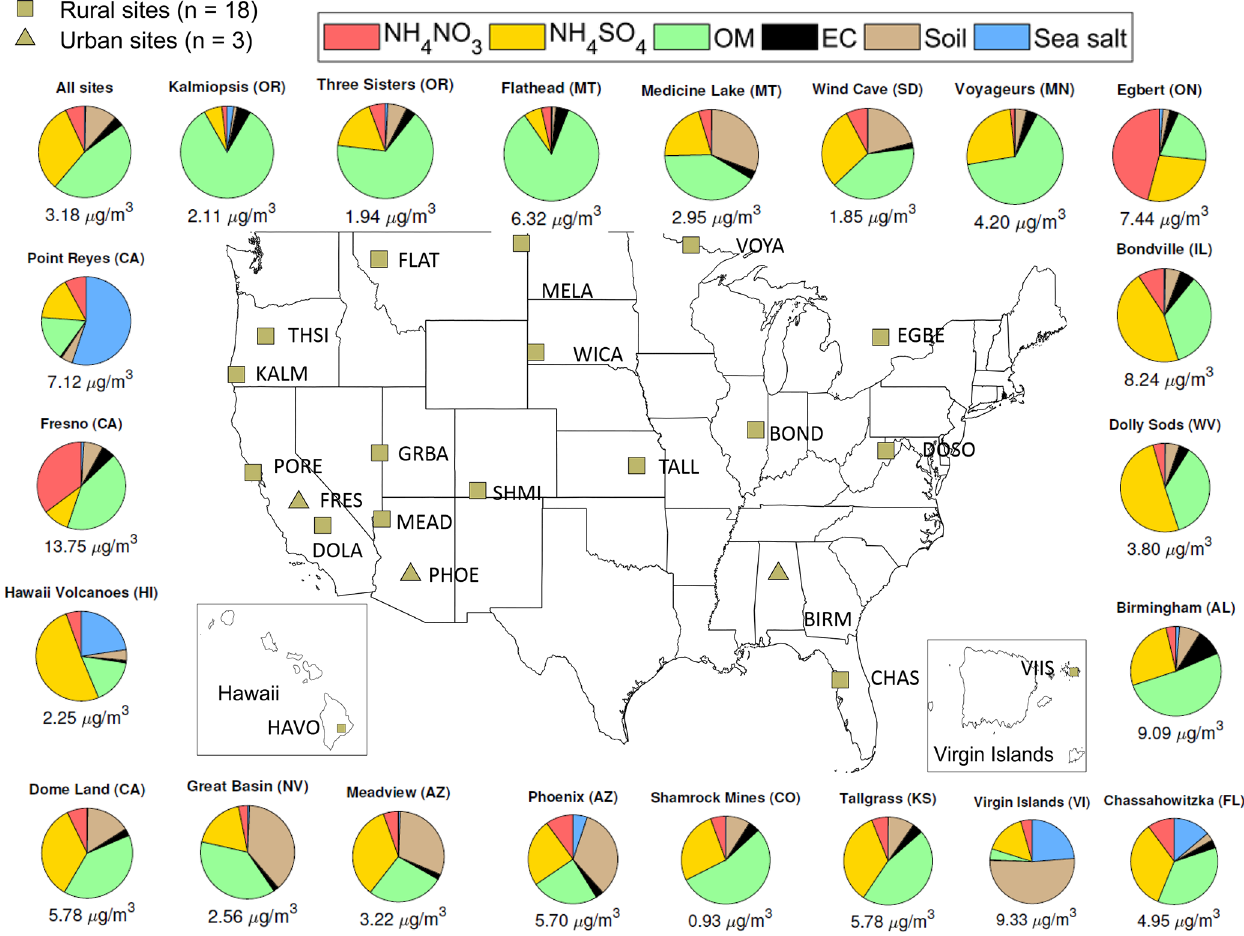
Figure 1. Spatial distribution, median PM 2 . 5 concentration and composition of the 21 representative sites. The composition is obtained from routine IMPROVE (non-FT-IR) measurements and the IMPROVE reconstructed fine mass equation (http://vista.cira.colostate.edu/Improve/ reconstructed-fine-mass/, last access: 15 March 2020) to calculate soil and sea salt. Sites are identified by the four letter site code which is the first four letters of a single word site name (Fresno = FRES) or the first two letters of the first and second word for two word site names (Dome Land = DOLA). The top left pie chart shows the median PM 2 . 5 composition across all sites and samples for